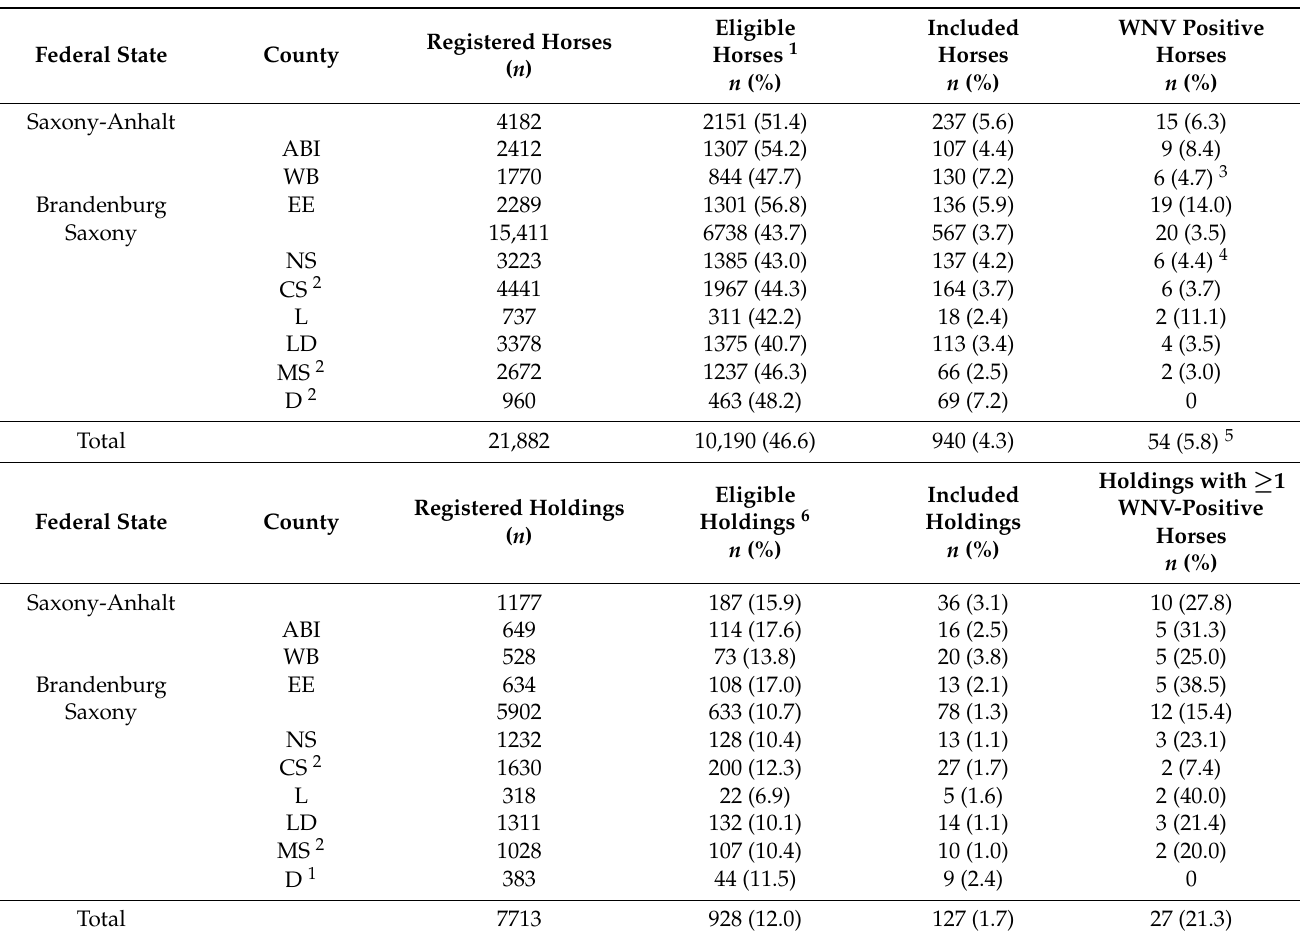
Table 1. Study population and seroprevalence of WNV infection in Eastern Germany at horse level ( top ) and holding level ( bottom ). Of 940 horses included in the study, three horses with inconclusive serological results were excluded for the purpose of